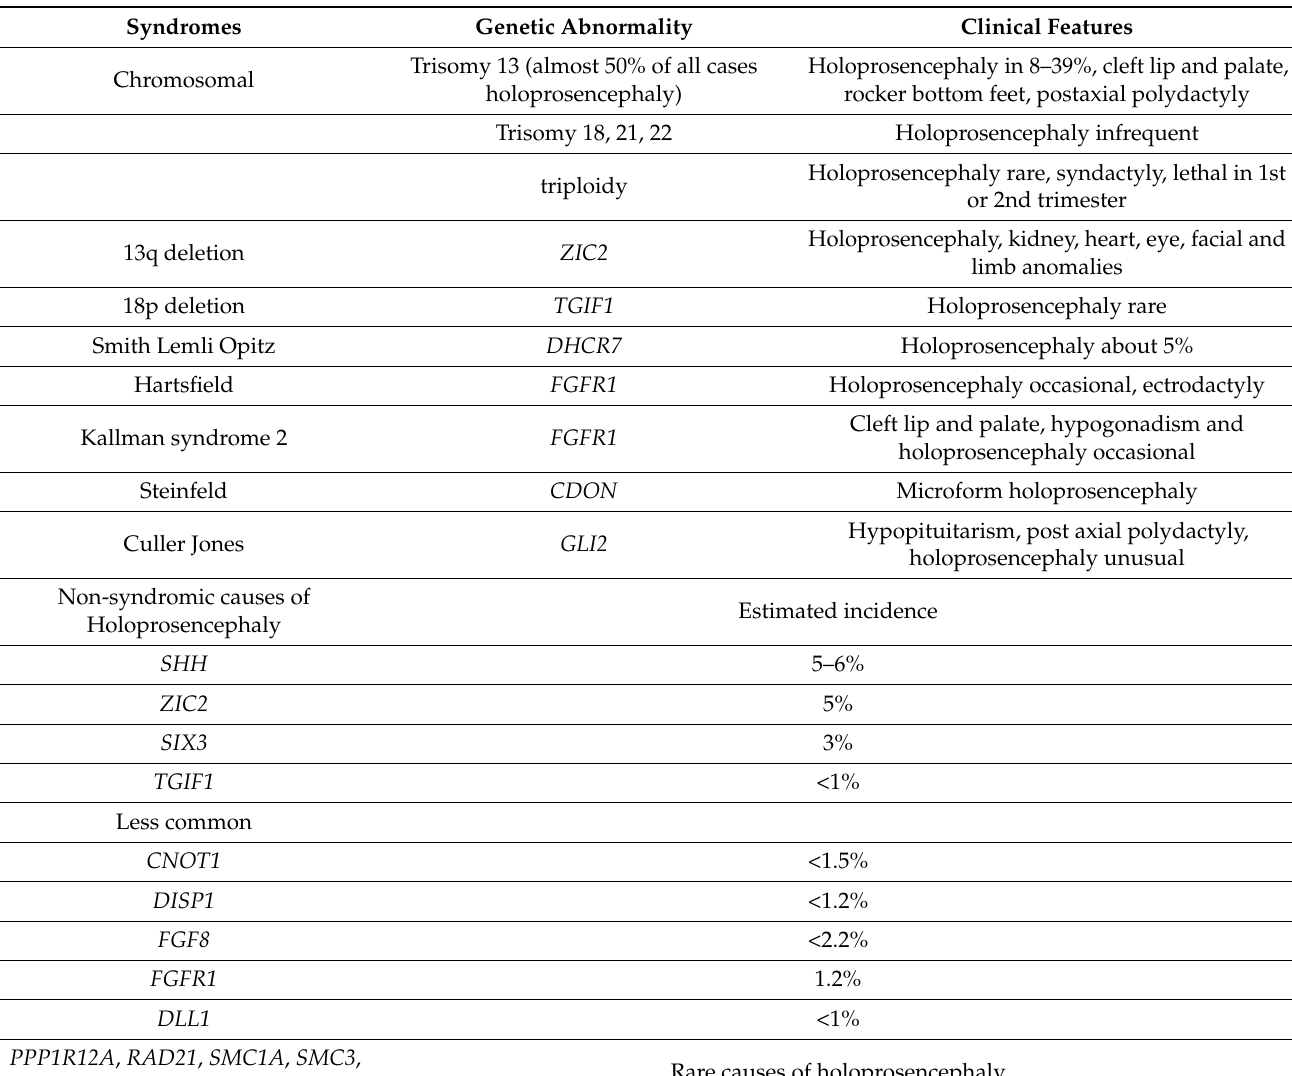
Table 1. Genetic Causes of